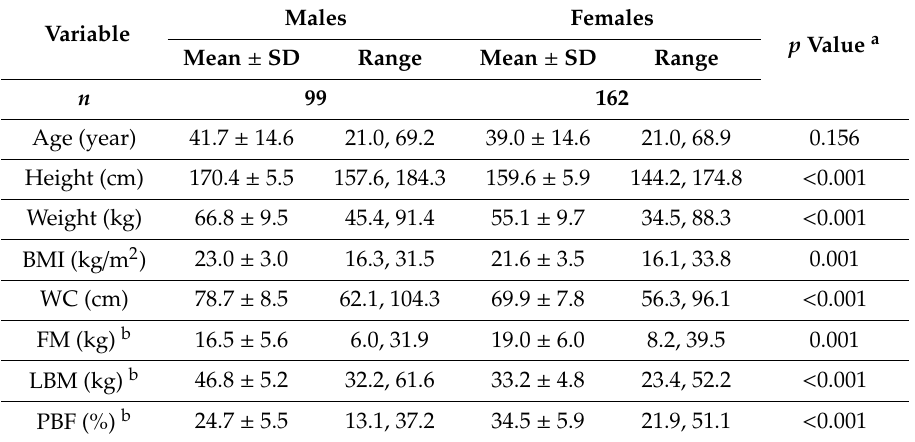
Table 1. Characteristics (mean ± standard deviation (SD)) of the study population. Variable